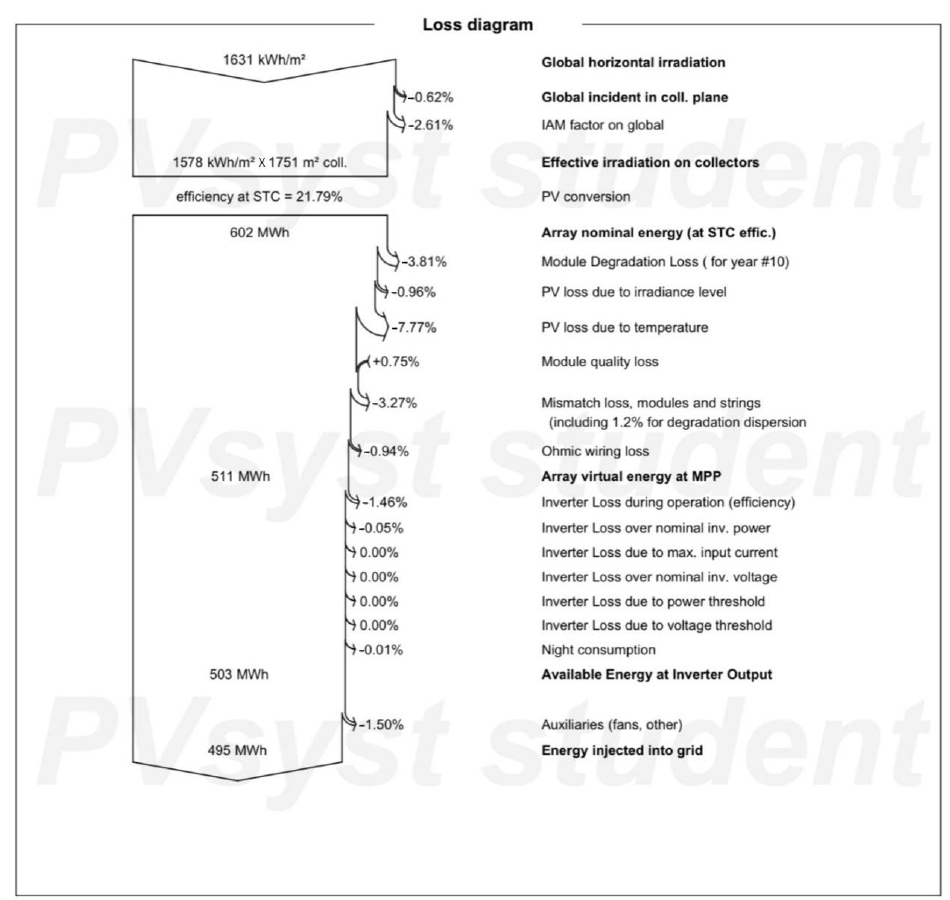
Figure 3. Loss diagram of energy for a year of expected production flowing through the PV system energy using PVsyt.